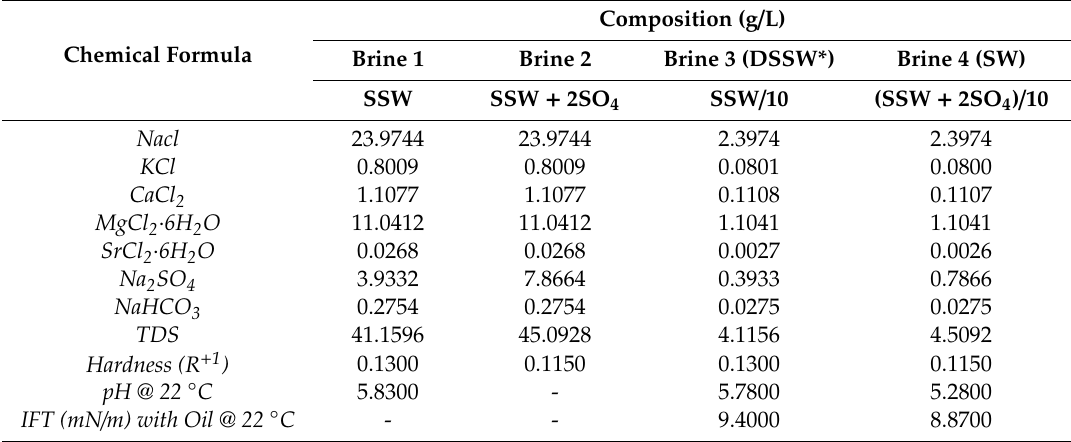
Table 2. Composition of the brines used in Brine Group B (BGB) to design modified water and to dissolve the polymer